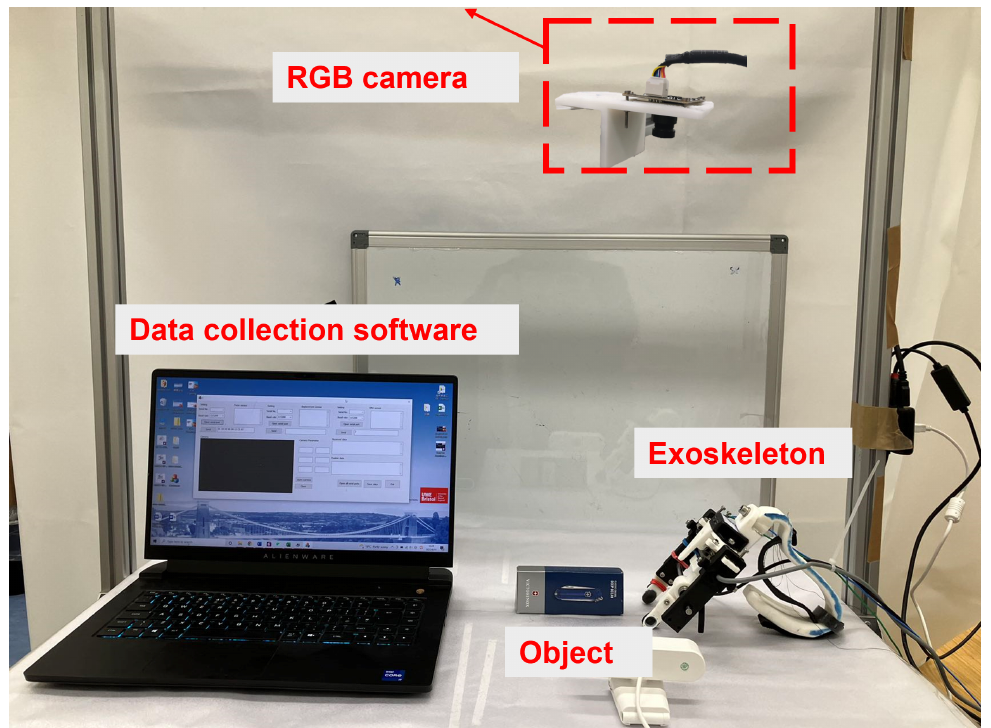
Figure 6. Experimental